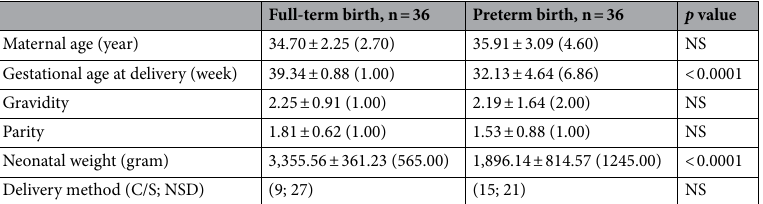
Table 1. Demographic data of participants and comparisons of clinical manifestations We tabulated demographic data and compared the clinical manifestations of preterm and FTB participants. The first five p values were calculated with a t test. The p value of the delivery method was calculated with the chi-square test. C/S and NSD denote cesarean section and normal spontaneous delivery, respectively. NS denoted no significance. Numerical data were presented as mean ± SD with interquartile range (IQR) highlighted in bracket. The two values separated by semicon in the brackets denoted the numbers of participants with cesarean section and normal spontaneous delivery, respectively.